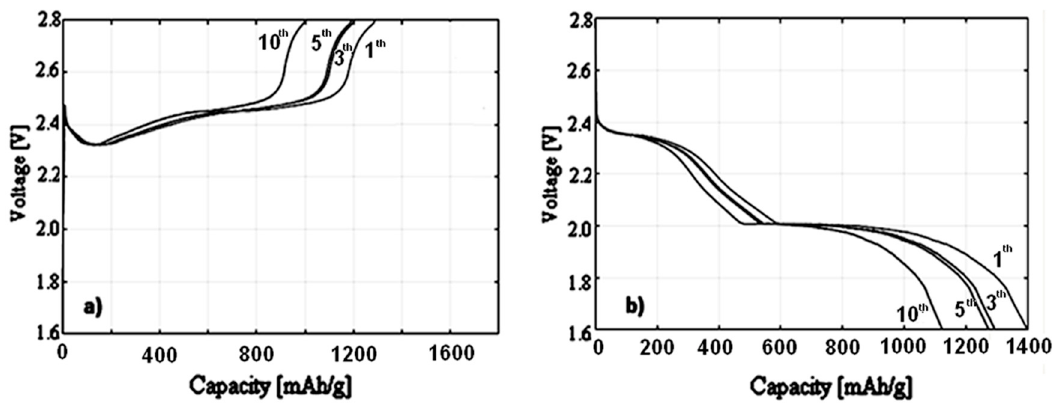
Figure 12. ( a ) Charge curves obtainedat C/10for first, third, fifth and tenth cycle and ( b ) discharge curves obtained for first, third, fifth and tenth cycle for core–shell S–TiO 2 materials.